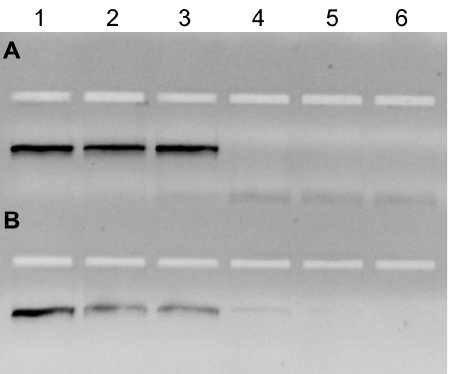
Figure 6. HLA-PCR SBT with R660V and AmpliTaq Gold. PCR amplification of six DNAs using either KlenTaq R660V (A) or AmpliTaq Gold (B). The HLA-DRB1 profiles of the genomic DNA are: lane 1: HLA- DRB1* 13:01:01, 13:02:01; lane 2: HLA-DRB1* 03:01:01, 11:01:01; lane 3: HLA-DRB1 01:01:01, 13:01:01; lane 4: HLA-DRB1* 08:01:03, 08:01:03; lane 5: HLA-DRB1* 01:01:01, 07:01:01; lane 6: HLA-DRB1* 07:01:01, 15:01:01.